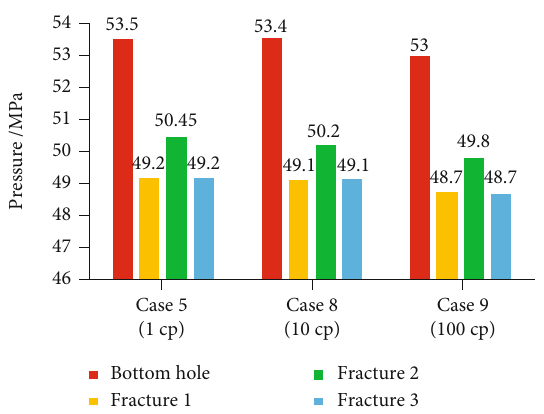
Figure 24: Bottomhole pressure and pressure at various fracture mouths when fracturing for 50s for three di ff erent fracturing fl uid